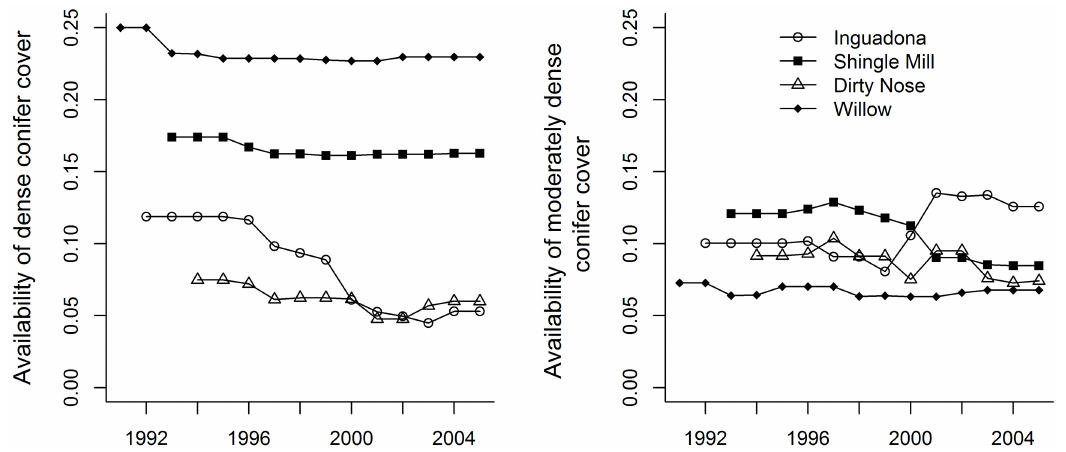
Fig 1. Availability (versus time) of dense ( (cid:21) 70%canopy closure, left panel) and moderately dense (40% (cid:20) ×< 70% canopy closure, right panel) conifer cover for each of four study sites, north-central Minnesota, 1991–2005. First- year baselinewas dependenton the year the site was incorporatedinto the study and habitat quantified.